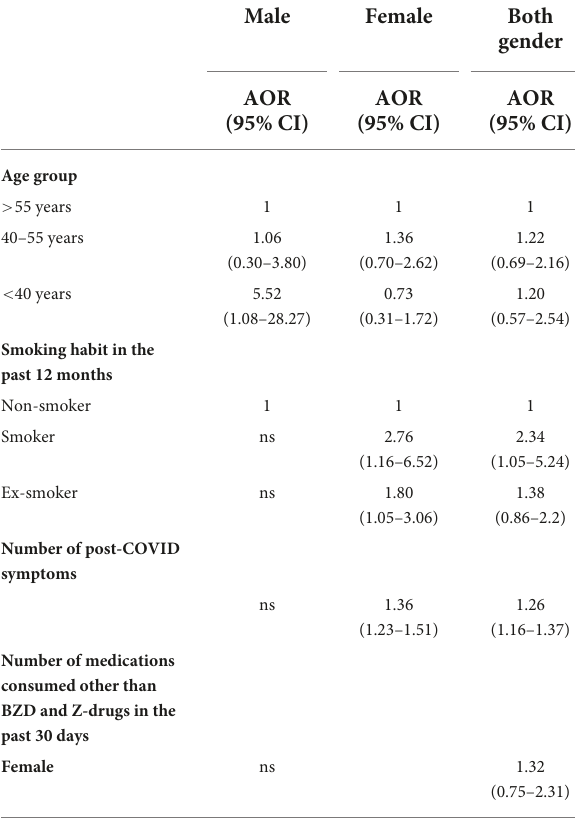
TABLE 3 Multivariable logistic regression analysis of factors associated with BZD and Z-Hypnotics consumption in patients with long